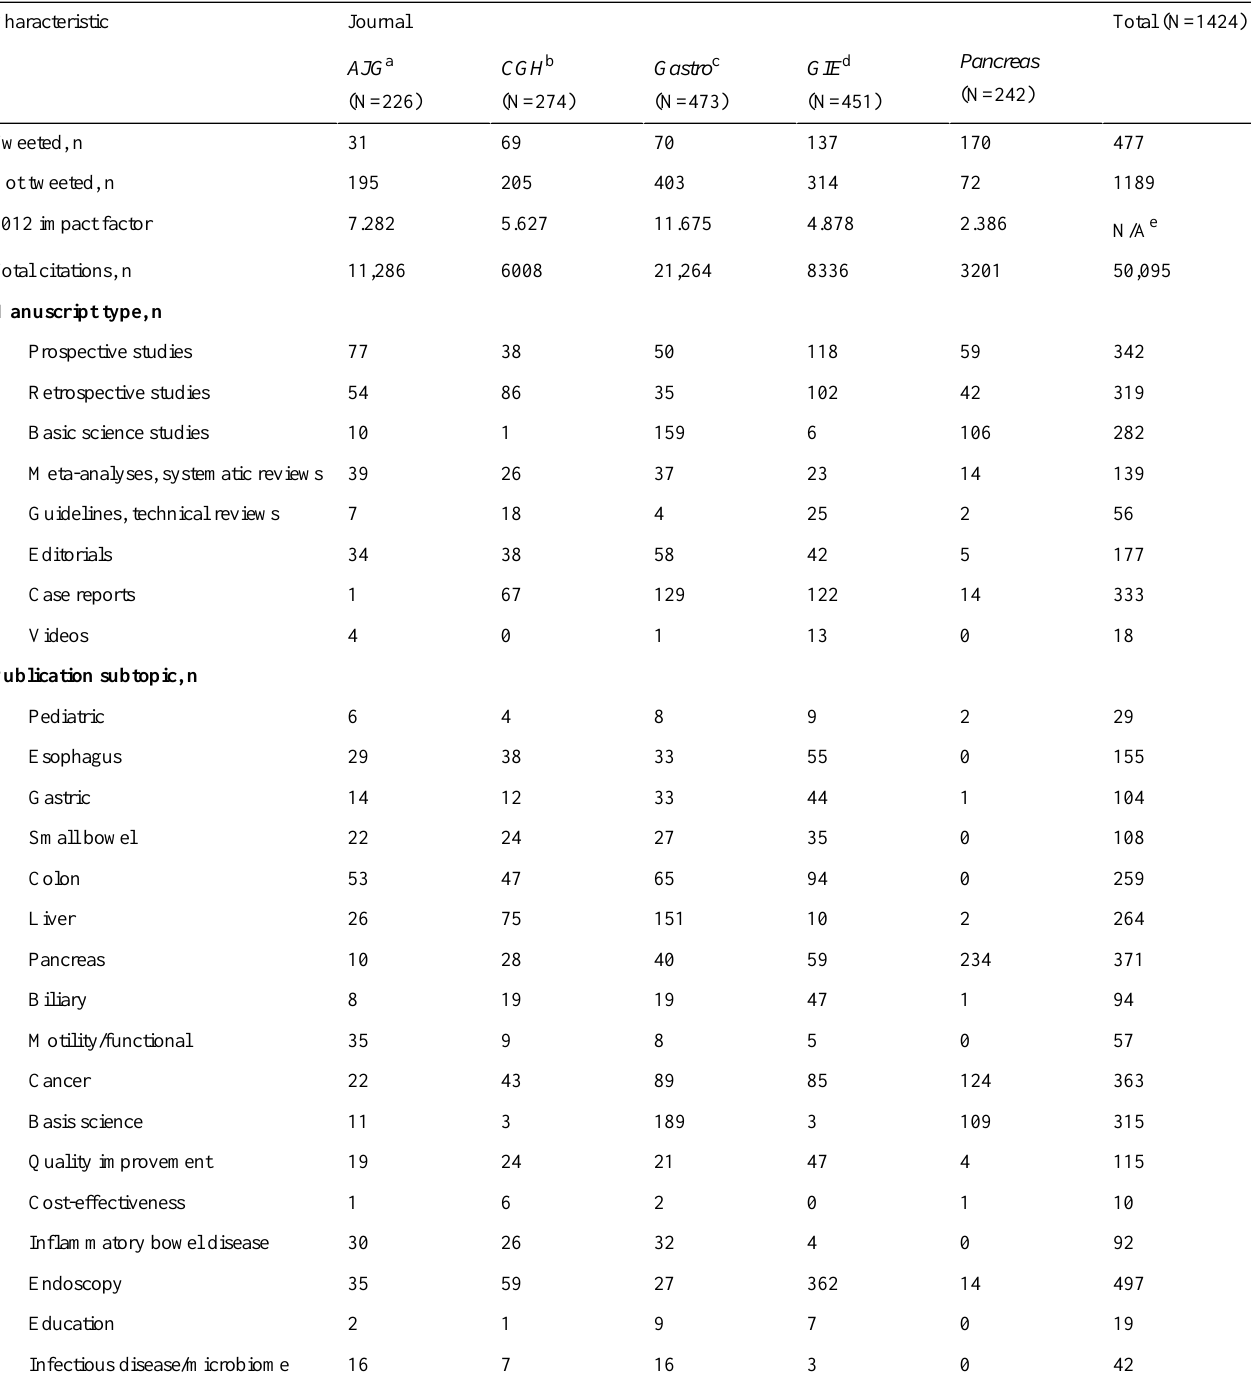
Table 1. Characteristics of the articles in the five gastroenterology journals (Twitter promotion, impact factor, total citations, and frequency of publication by manuscript type and